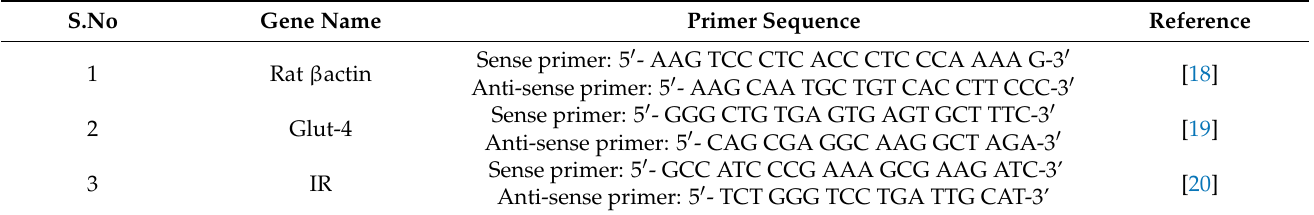
Table 1. List of rat primers